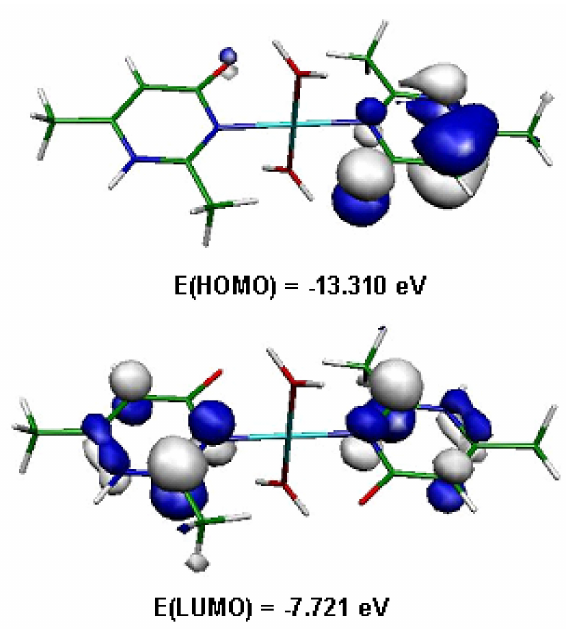
Figure 11. Frontier orbitals in ( 1 ).